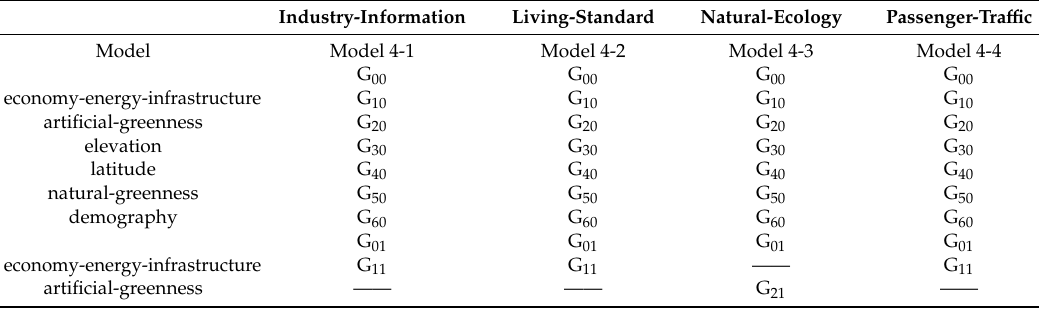
Table 3. Coe ffi cients of explanatory factors in Model